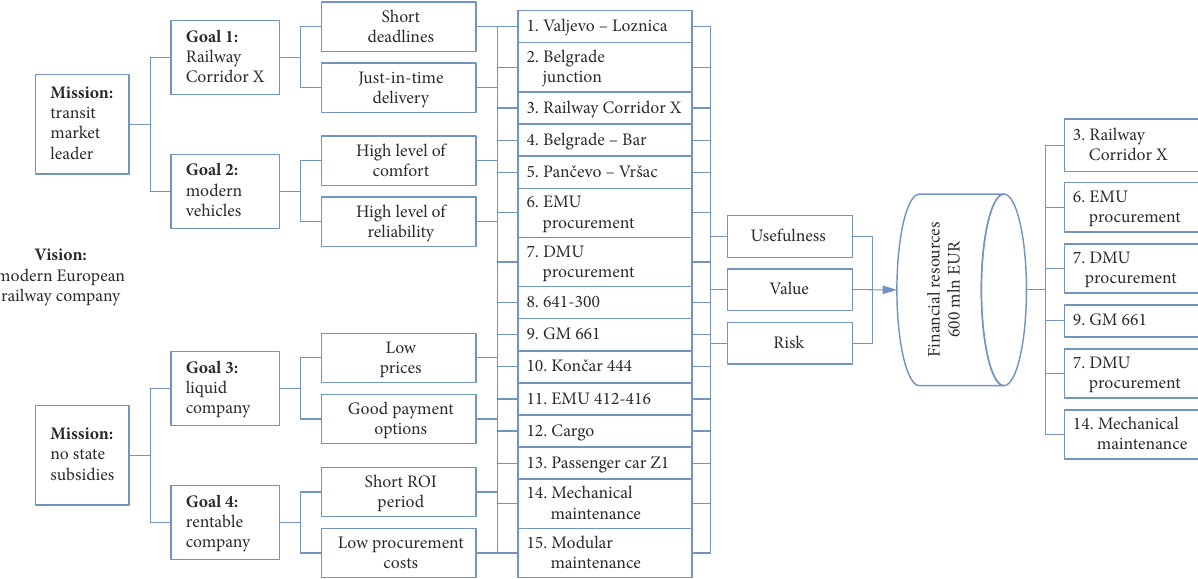
Figure 2. Serbian Railways – modernization projects selection model in relation to the strategic goals (created by